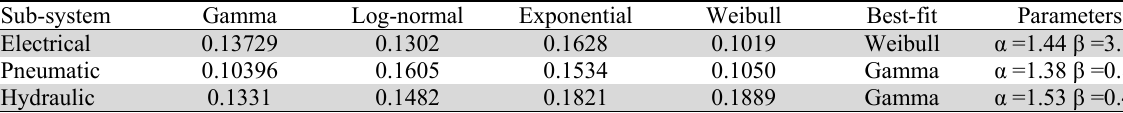
The results of best-fit distributions for TTR data set